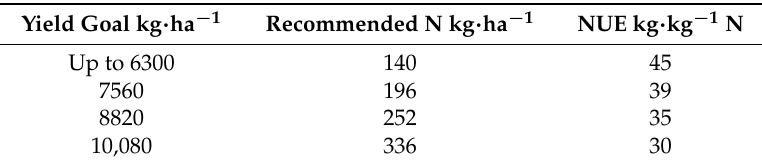
Table 3. Fertilizer recommendations (kg · ha − 1 ) and nitrogen use efficiency (NUE) for maize grown in silty clays, silty clay loams, and clays, based on yield goal